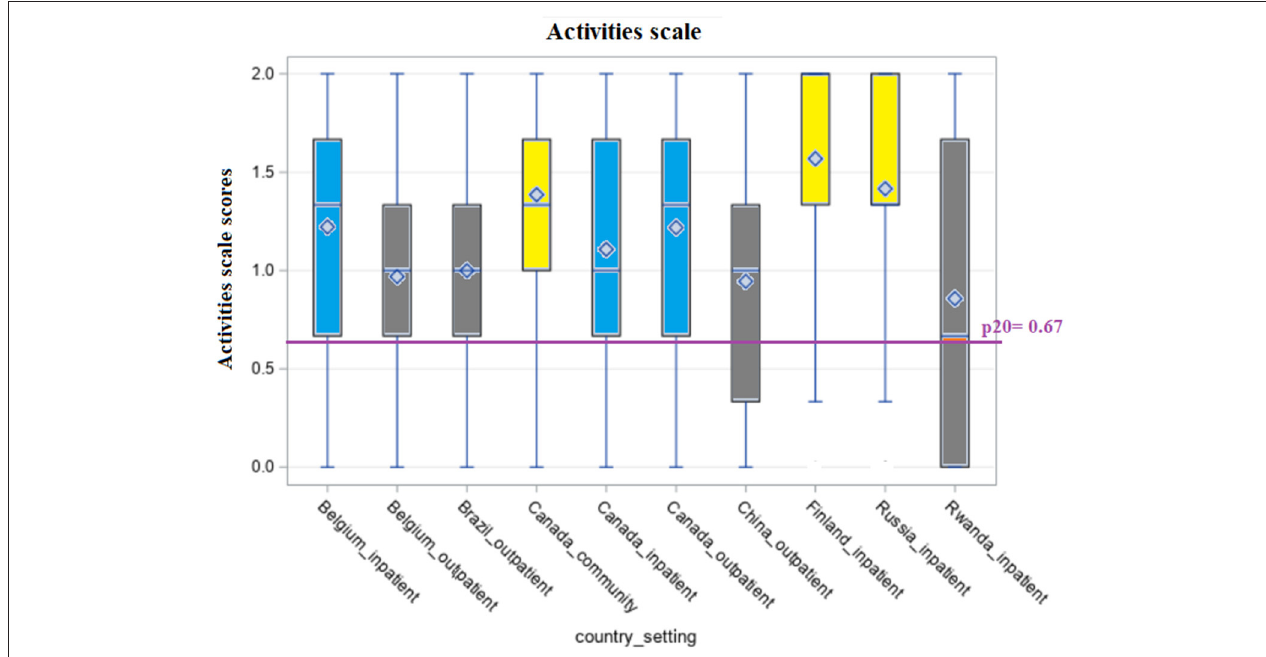
FIGURE 4 | Distribution of scores of the scale “Activities” across countries and settings.